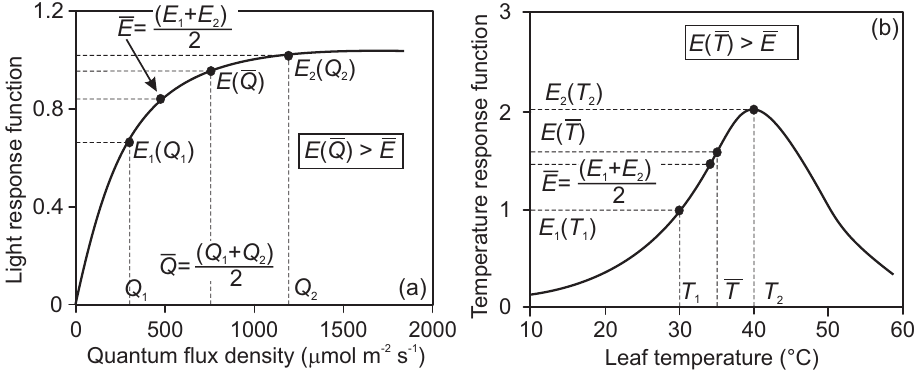
Fig. 9. Illustration of the averaging problem in isoprene emission responses to light, Q , (Eq. 16, a ) and leaf temperature, T L (Eq. 17, b ). Because of non-linearity of isoprene emission vs. light responses (a) , the average of any two isoprene emission rates ( ¯ E) simulated at light intensities Q 1 and Q 2 ( E(Q 1 ) and E(Q 2 ) , ¯ E = (E(Q 1 ) + E(Q 2 )) /2), is always lower than the value predicted using the average light, E( ¯ Q) (Jensen’s inequality for concave functions), except if both the Q 1 and Q 2 values come either from a region of the curve where the emission rate is independent of light (light saturation) or from very low light, where the emission rate scales close to linearly with quantum flux density. Analogously, the true average emission rate simulated for two different temperatures is lower than that predicted for the average temperature ( ¯ T ) in (b) in the local concave range of the temperature response curve. However, as the temperature response curve is convex in lower temperatures, the true average is larger than the one predicted using average temperature for this range. For instance, the true average response factor for temperatures 15 and 25 ◦ C is 0.347, while the response factor corresponding to the average T of 20 ◦ C is 0.281. Averaging the values above and below the temperature optimum can also result in either higher or lower values of true average vs. the average based on ¯ T . These simulations were conducted with original Guenther et al. (1991) isoprene emission model parameterization.